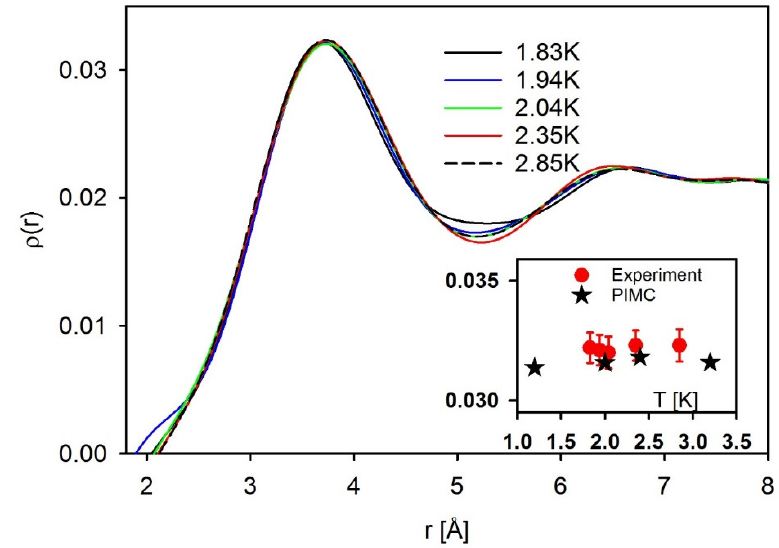
Figure 5. Snapshot PDF, ρ 0 g ( r ), obtained by integration of DyPDF over energy by Equation (4) at various temperatures [29]. The inset shows the variation of the first peak height with temperature, by experiment (circles) and path-integral Monte-Carlo (PIMC) simulation (stars).